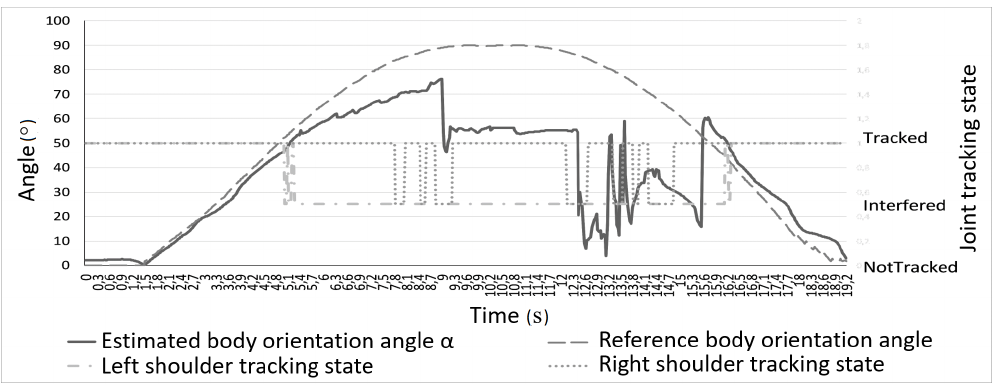
Figure 4. Shoulders joints tracking state in relation to body rotation angle α